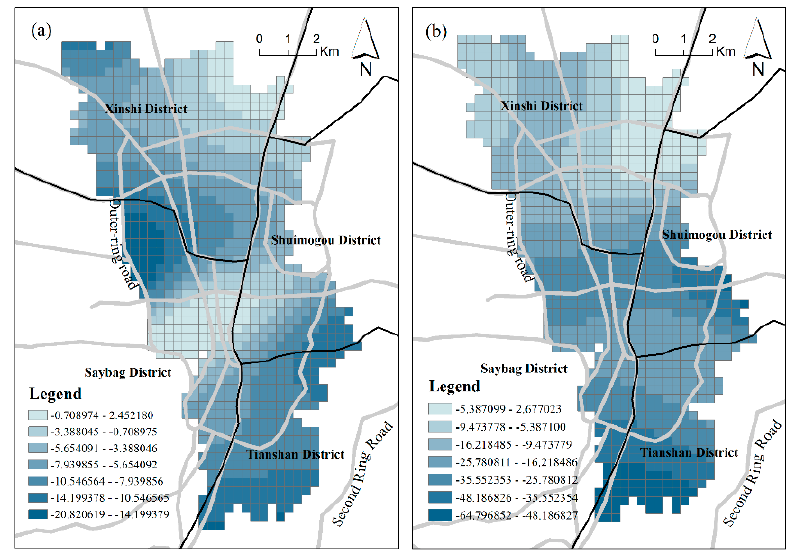
Figure 6. The coefficient of Mdis_DC : ( a ) Model 1; ( b ) Model 2.